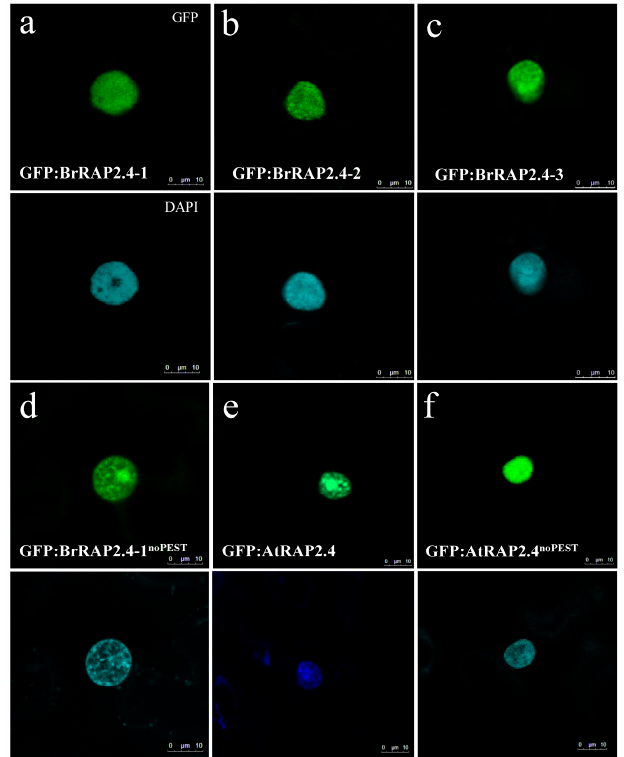
Figure 6. Nuclear Localization of GFP:RAP2.4 proteins in transient expression assays using tobacco leaves. ( a – c ) BrRAP2.4-1 to -3. ( d ) BrRAP2.4-1 noPEST . ( e ) and ( f ) AtRAP2.4 and AtRAP2.4 noPEST . Upper part always: confocal pictures showing GFP fluorescence, lower part always: confocal images showing DAPI fluorescence to indicate localization of the